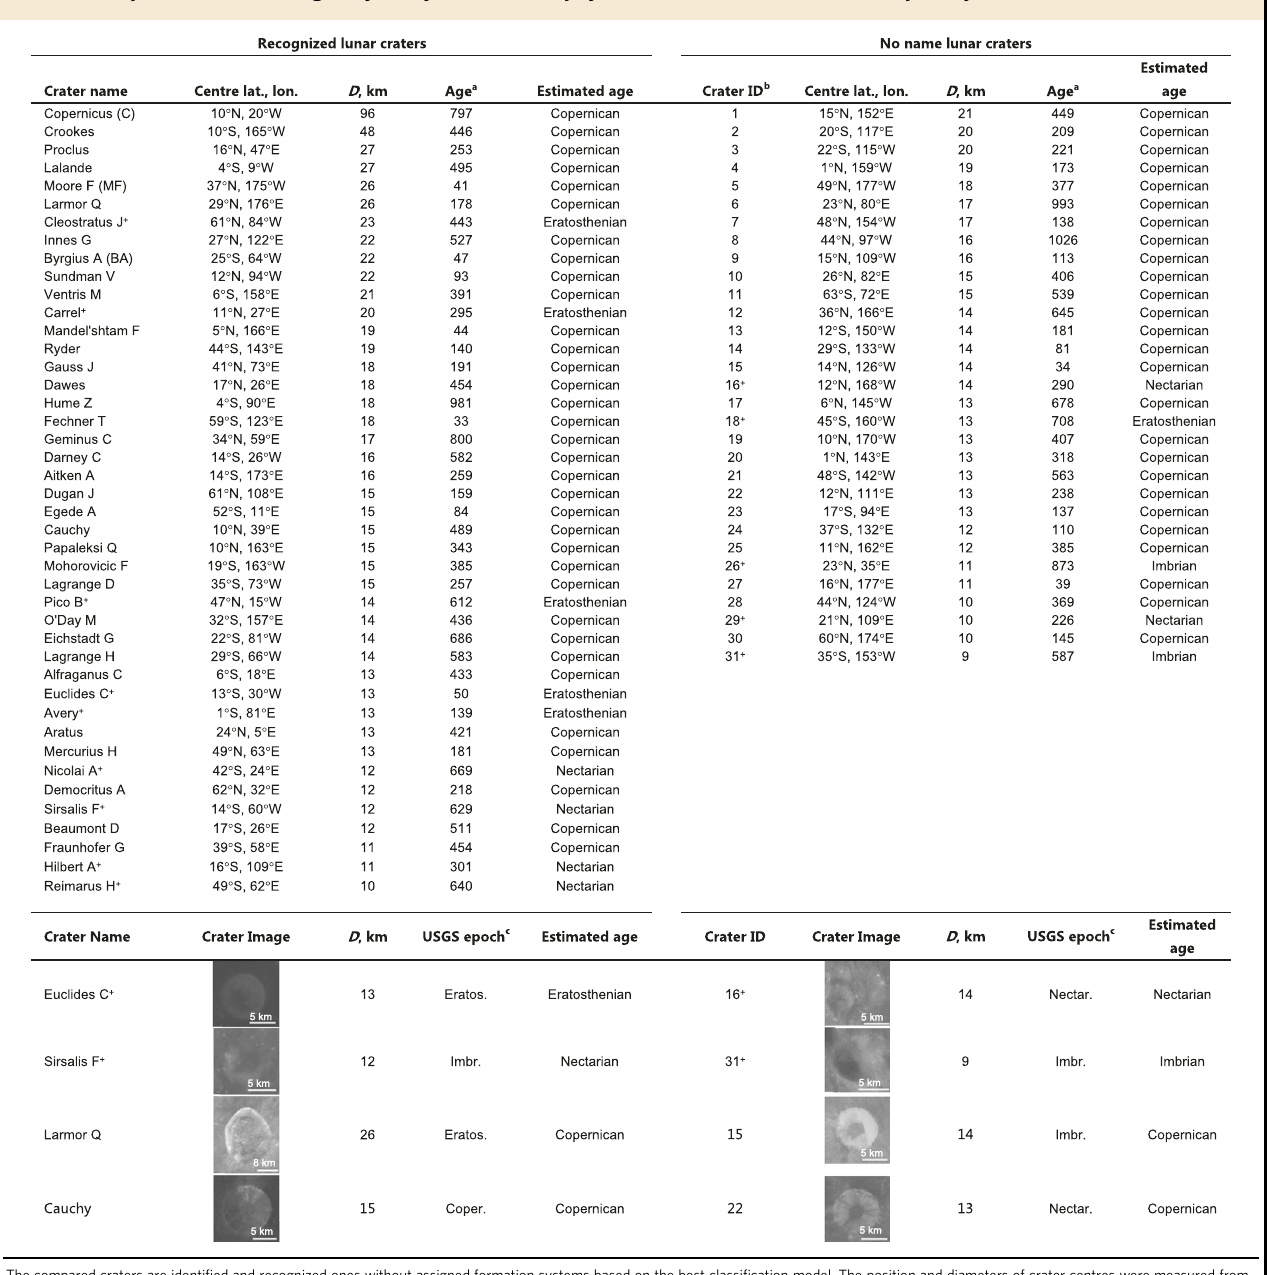
Table 5 Comparison of crater ages by analysis of thermophysical characteristics of lunar impact